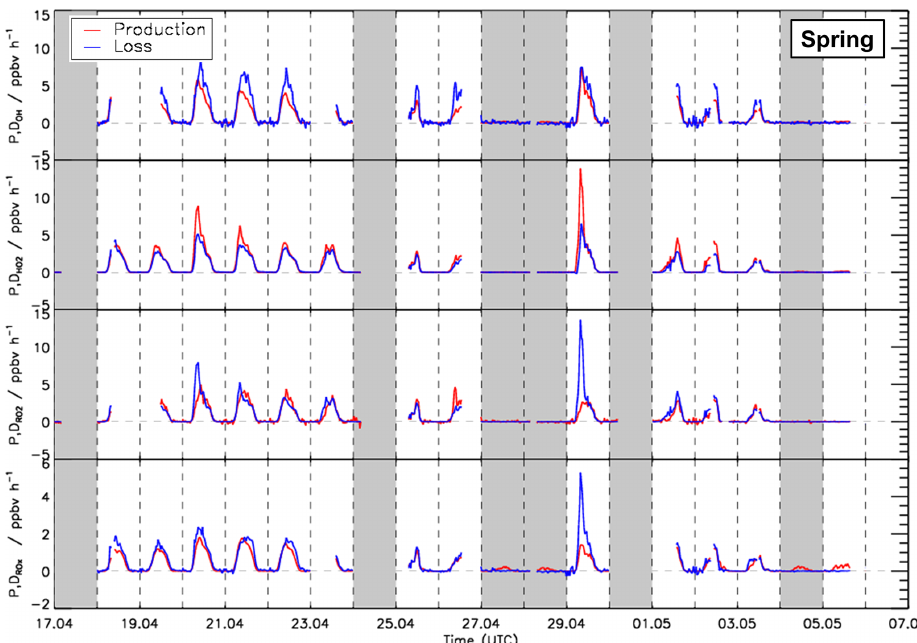
Figure 6. Time series of total production and destruction rates of OH, HO 2 , RO 2 , and RO X radicals in the spring period of the JULIAC campaign. Vertical dashed lines denote midnight. Grey areas indicate calibration days and days when the chamber roof was closed.